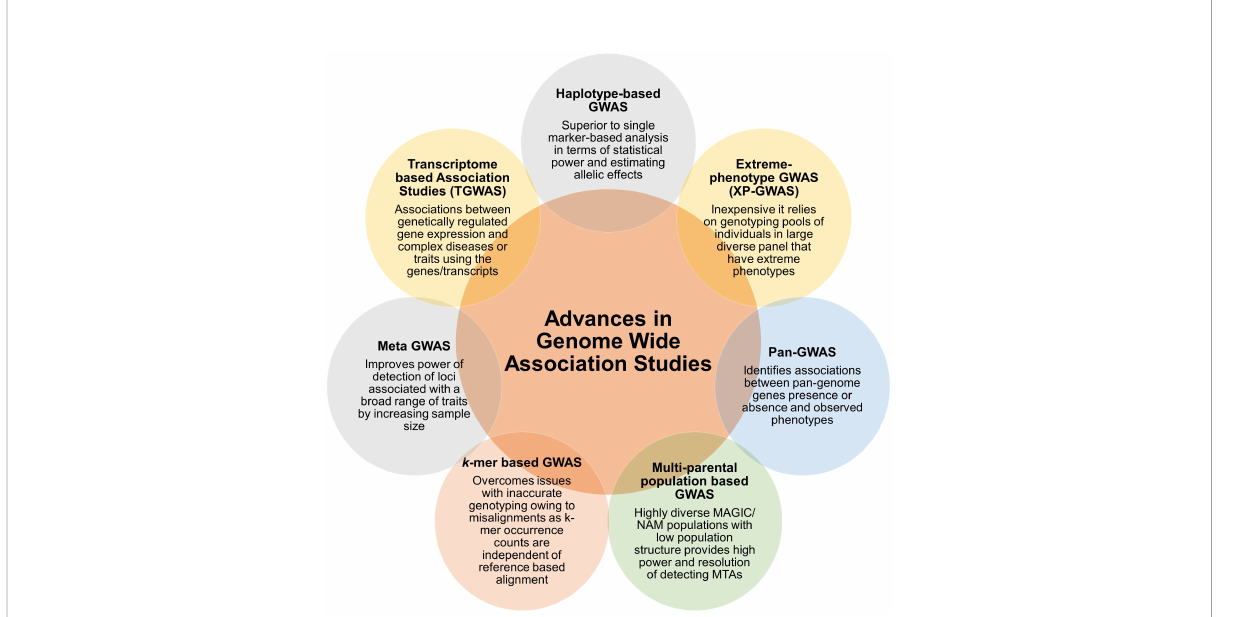
FIGURE 2 Summary of advances in association analysis. Different types of GWAS approaches are arranged in the chronological order, starting with GWAS based on halpotypes, extreme phenotypes, pangenomes, multi-parent populations, k -mers, meta data and transcriptomes. Key feature or major advantage of the approach is also